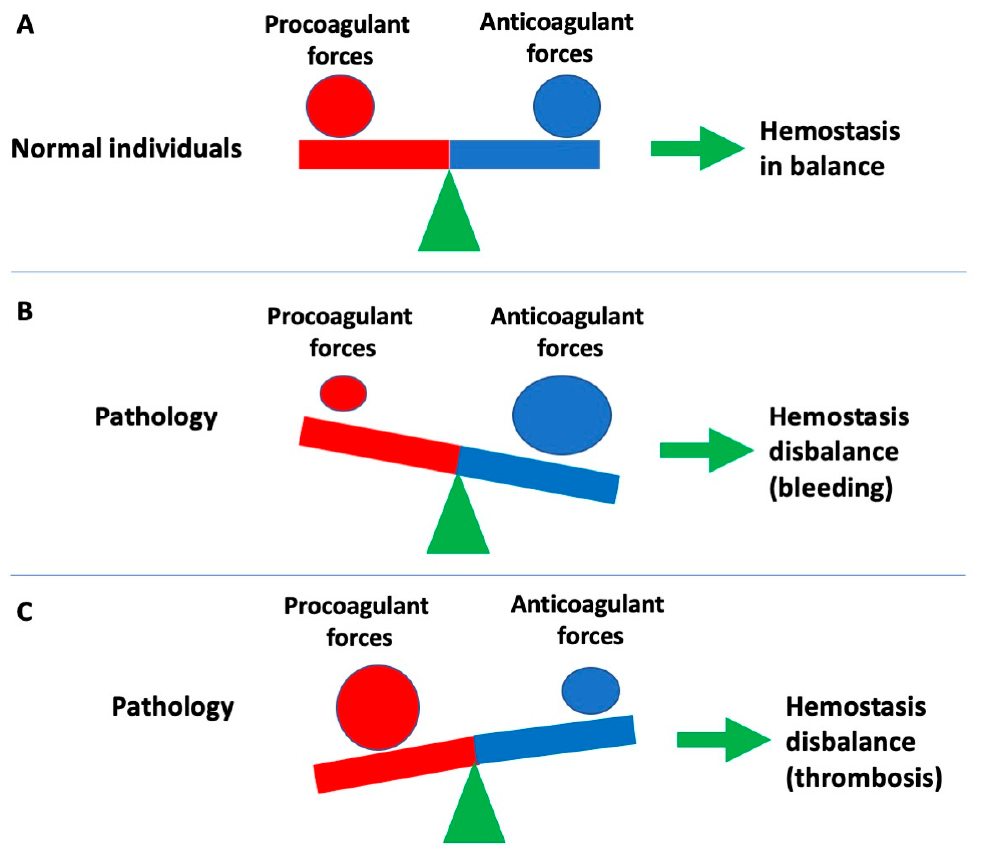
Figure 1. Hemostasis can be considered as reflecting a balance of procoagulant and anticoagulant forces. ( A ) In normal individuals, these forces are in balance, and this acts to prevent overt bleeding or thrombosis. ( B ) In some pathological states, a relative reduction in procoagulant forces or an excess of anticoagulant forces, can lead to a hemostasis disbalance and bleeding. ( C ) In some pathological states, an excess of procoagulants forces, or a relative reduction in anticoagulant forces, can lead to a hemostasis disbalance and thrombosis.